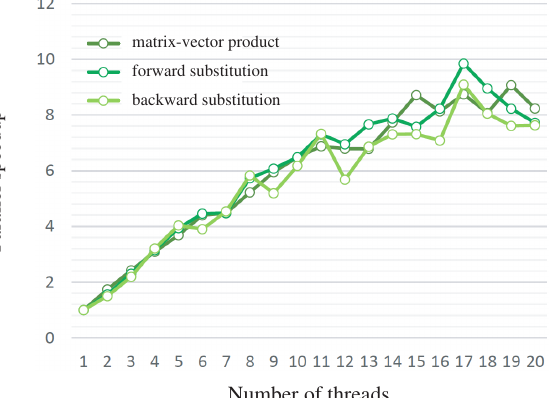
Figure 15. Parallel acceleration of each component for the 101 × 101 × 102